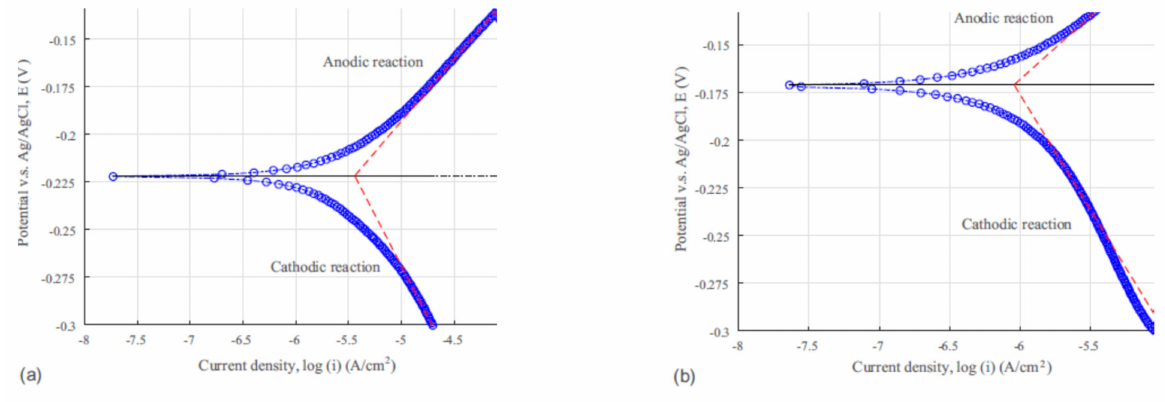
Figure 7. Corrosion testing results for uncoated Cu specimen ( a ) and coated Cu specimen ( b